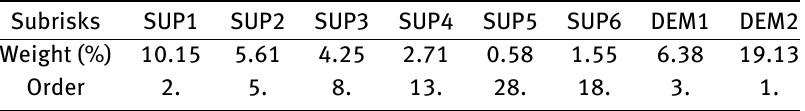
Table 3: Resulting values of subrisks weights – Part I.